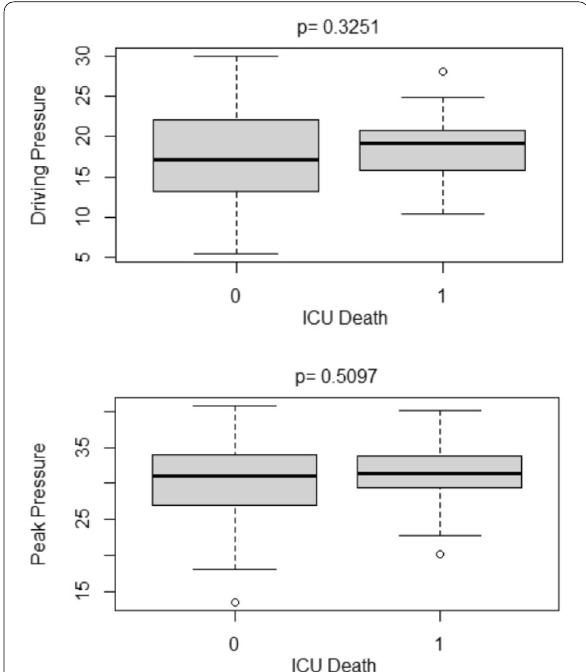
Fig. 3 Boxplots of mean DP and mean peak pressure before ECMO